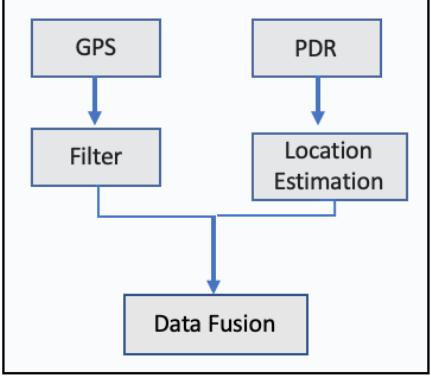
Figure 10. Outdoor Data Fusion presented in Reference